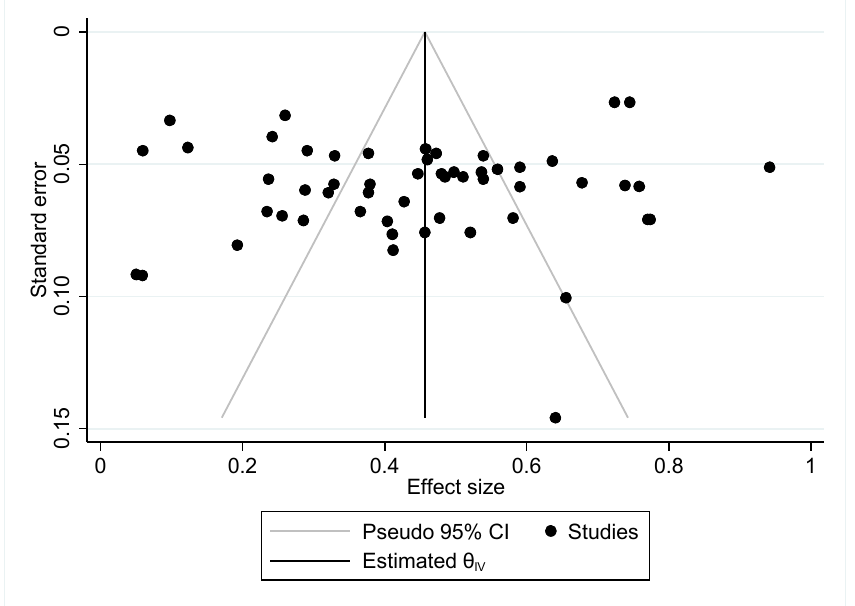
Figure 6. Funnel plot of the 39 articles that investigated the association between environmental concern and consumer purchase behavior.